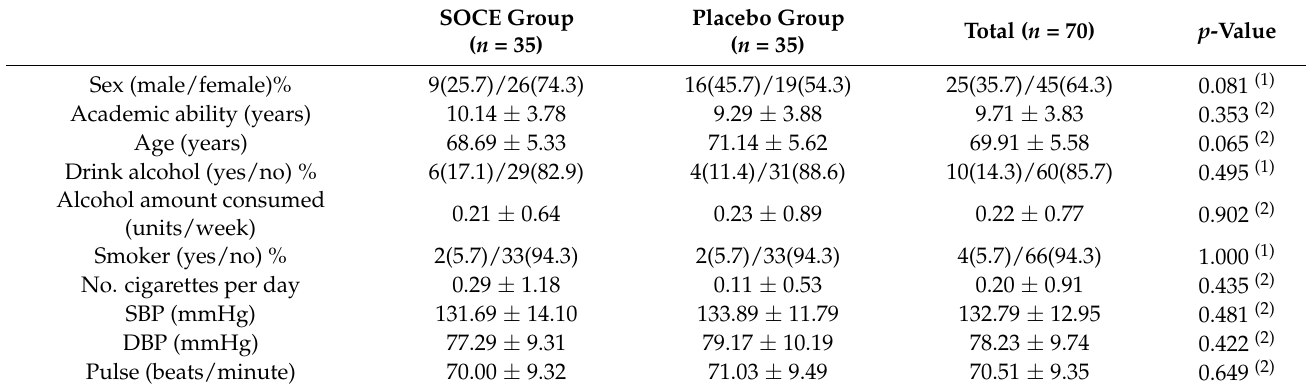
Table 2. Demographic characteristic of study